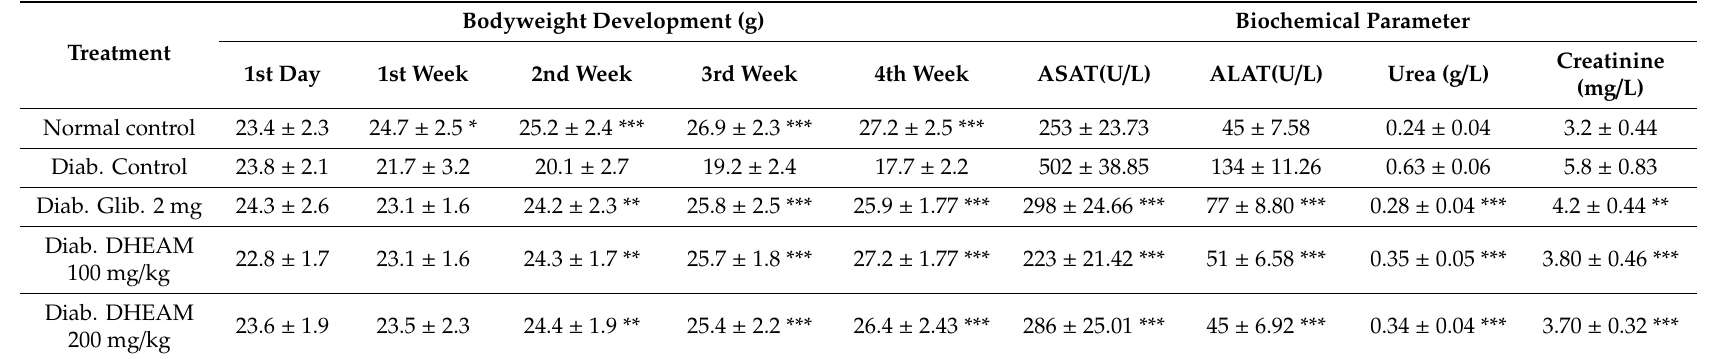
Table 2. E ff ect of DHEAM on bodyweight development and biochemical